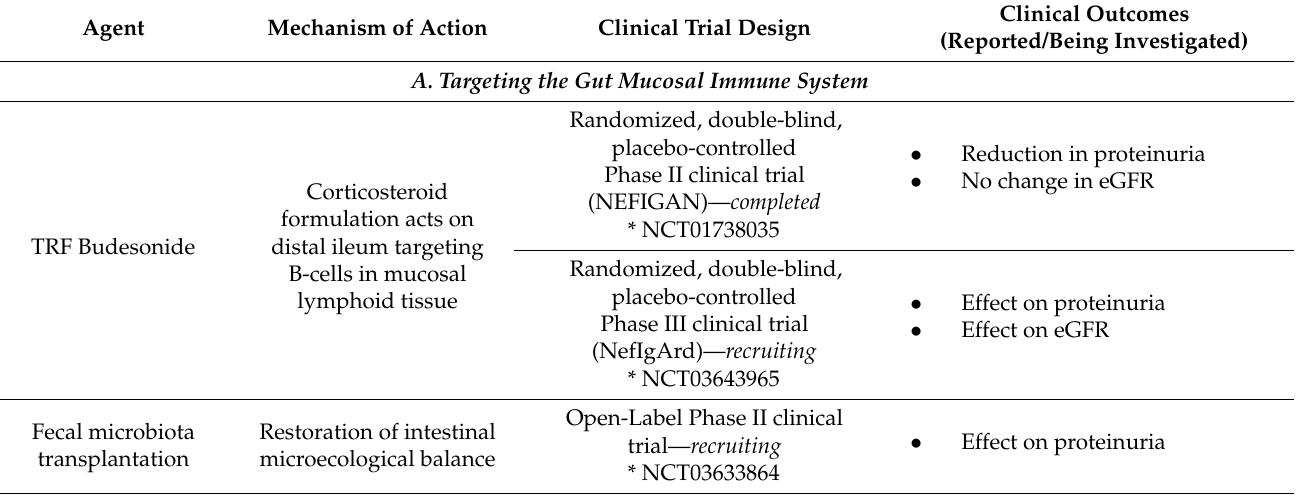
Table 1. Novel Therapies for Treatment of Primary IgA